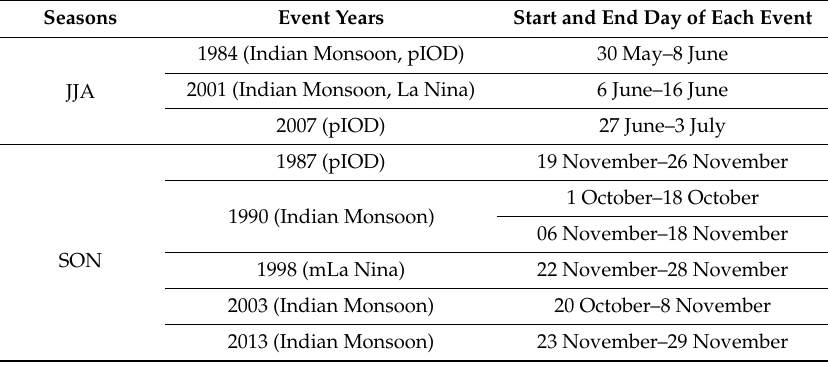
Table 2. The extreme high streamflow events at Baronda station for JJA and SON seasons, where each event is selected from the persistence occurrence of high flows for 6 days or more (1980–2013).